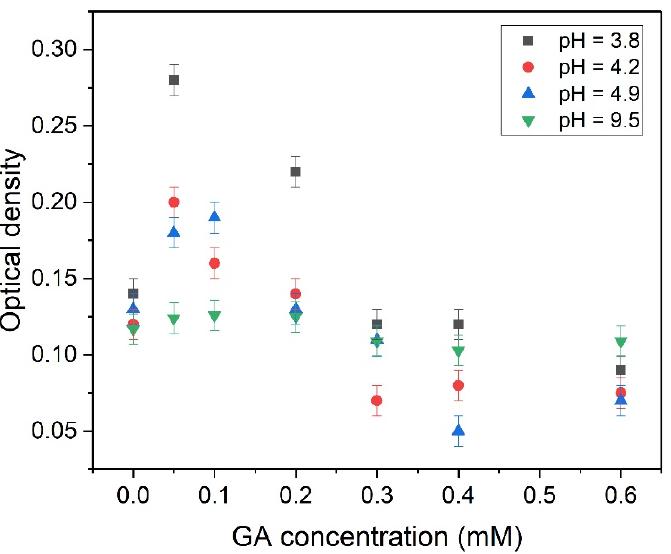
Figure 3. The dependence of the optical density of a mixture of nifedipine + GA on the concentration of GA at different pH values (3.8, 4.2, 4.9, and 9.5) at 342 nm.